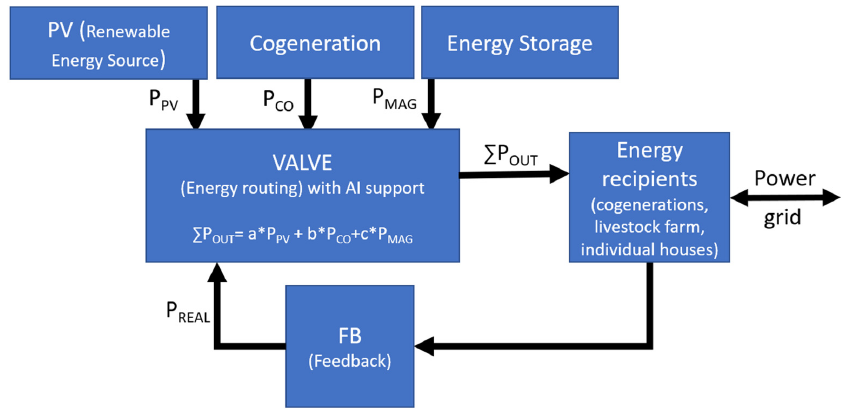
Figure 3. Energy routing through a smart valve—inputs and outputs.